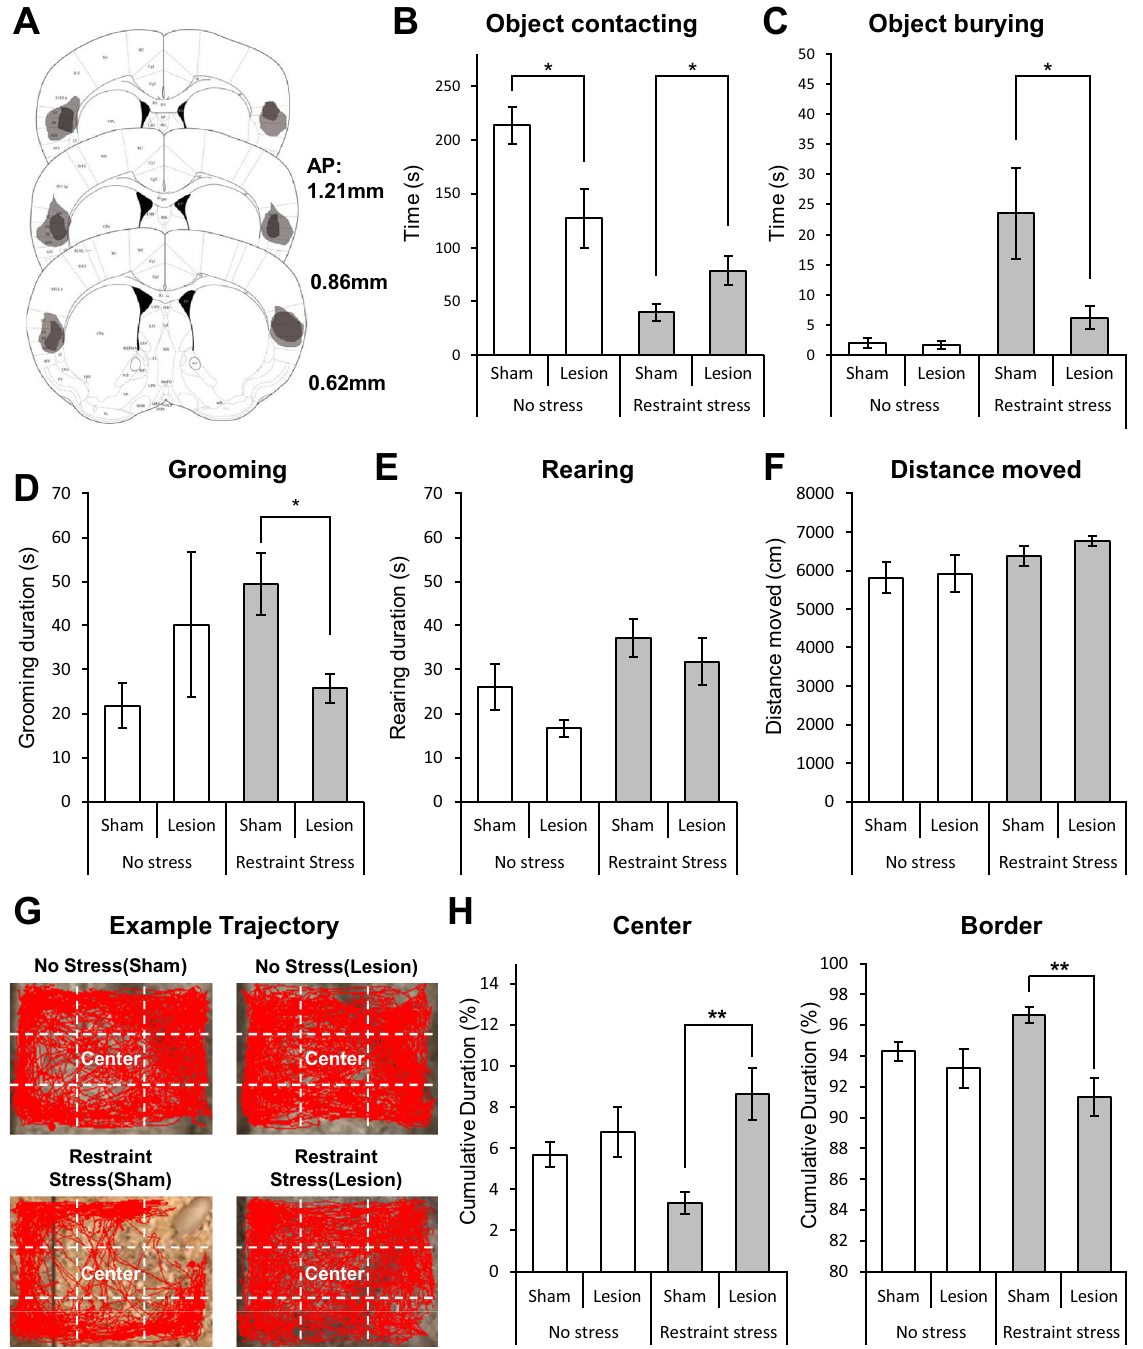
Figure 3. Electrolytic lesion of the aIC in fear and anxiety-like behaviors. ( A ) Histological evaluation of the extent of damage made with electrolytic lesions in a series of sections of the insular cortex. Darker areas indicate complete ablation. Lighter areas indicate partial tissue damage. ( B ) Duration of contacting a restrainer- resembling object in four different groups: no stress (sham) n = 8, no stress (lesion) n = 7, restraint stress (sham) n = 9, and restraint stress (lesion) n = 8. ( C ) Burying of a restrainer-resembling object in different groups (same groups as in B ). ( D ) Cumulative grooming duration difference between groups. ( E ) Cumulative duration of rearing behavior of different groups. ( F ) Total distance moved in each group (same group in B ) during the experiment. ( G ) Example trajectory of four different groups. Red lines indicate trajectory of a mouse during the test. White dashed lines show how the center and border zones are defined in each experimental cage. ( H ) Cumulative duration in the center or border zone of different groups. ( B–F, H ) All data are presented as mean ± SEM. Mann–Whitney U test was used to assess statistical difference between groups within the no-stress and the restraint-stress group (*p < 0.05, **p <